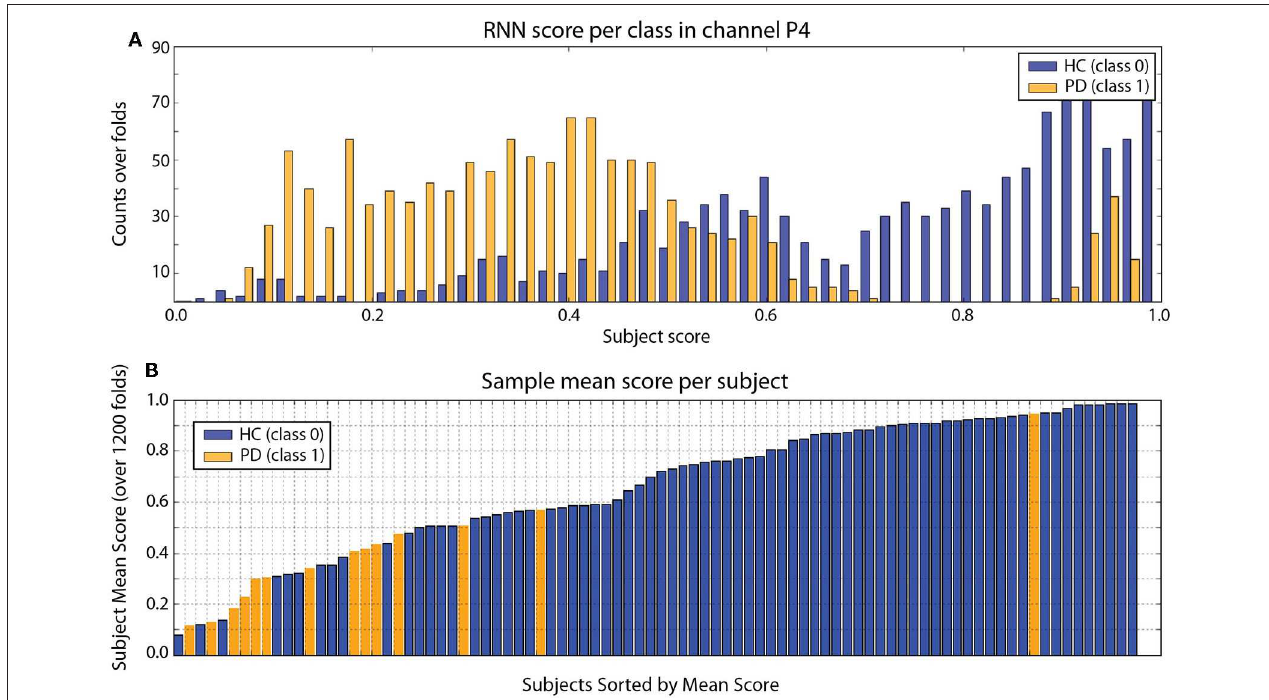
FIGURE 3 | (A) RNN Frame score histogram per class (HC in blue, PD in orange) using one channel (P4). (B) Subject mean score across folds. In this particular run, with mean ACC = 80%, AUC = 87% (both ± 1%). There are clearly some subjects that are not classified correctly (this is consistently with DCNN results). The PD outlier is unusual in terms of other metrics, such as slow2fast ratio (EEG slowing) or LZW complexity ( 8). Results from the DCNN are very